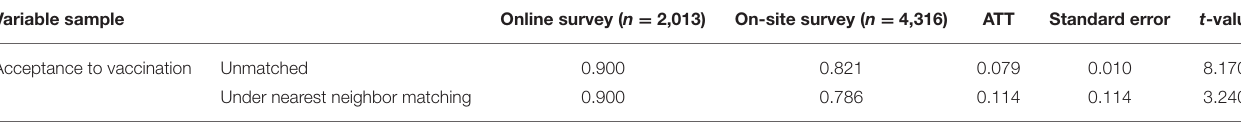
TABLE 3 | The results of propensity score matching using a nearest neighbor matching method.